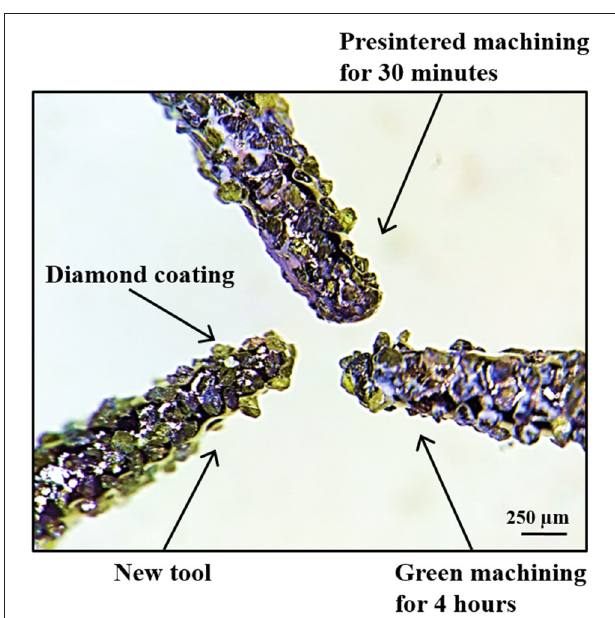
FIGURE 11 | Stereo zoom microscopy at 5X of tools after green and pre-sintered machining along with new tool (indicates the removal of the diamond coating during machining of partially sintered